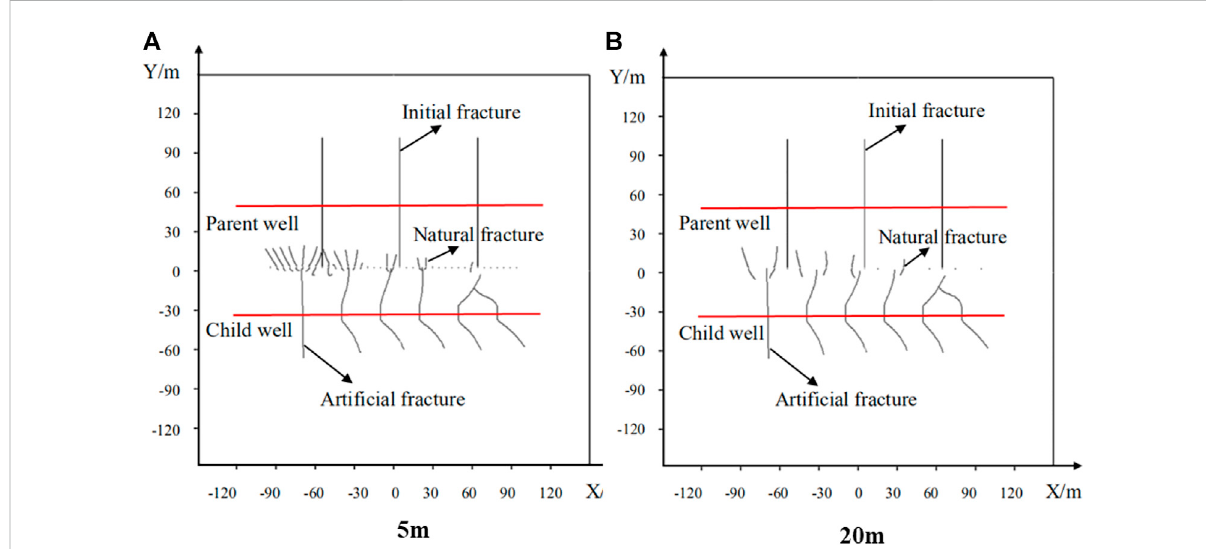
FIGURE 17 Fracture propagation trajectories under different natural fracture densities.